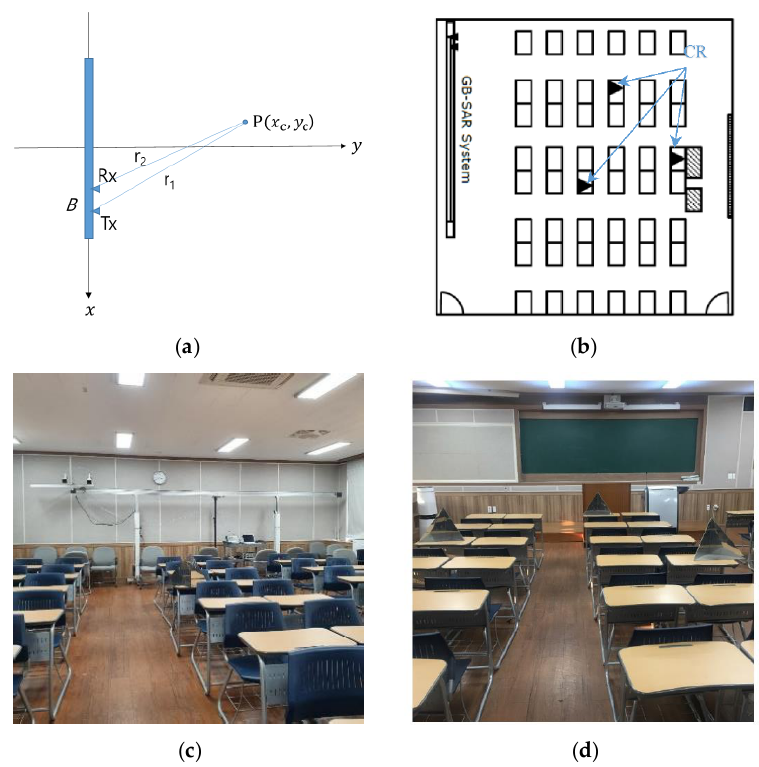
Figure 1. A bistatic ground-based synthetic aperture radar (GB-SAR) experiment inside a lecture room with ( a ) a schematic geometry, ( b ) a diagram of the indoor targets and system, ( c ) a photo of the system and the targets, and ( d ) a photo of the lecture room seen from the system with chairs and three trihedral corner reflectors (CR). Table 1. System parameters for a bistatic GB-SAR experiment.